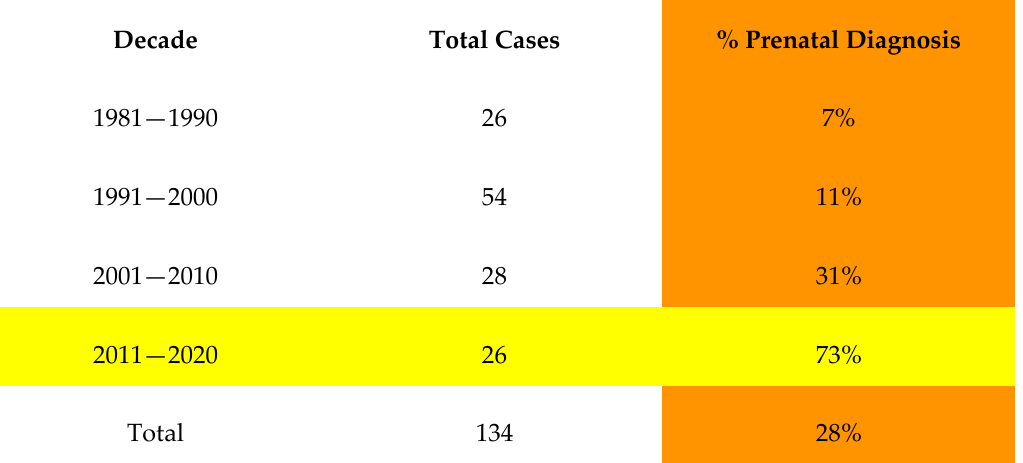
Figure 1. Demonstrating increasing prenatal detection rate of IAA by decade.